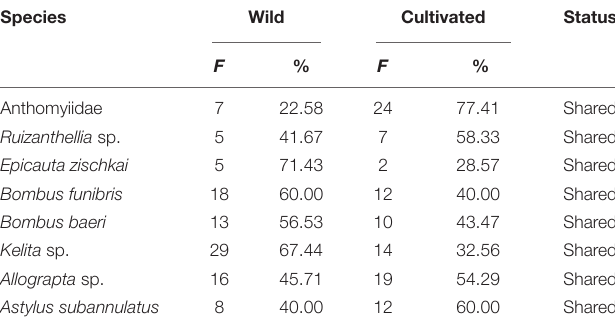
TABLE 6 | Foraging activity of flowers visitor throughout four consecutive days. Species